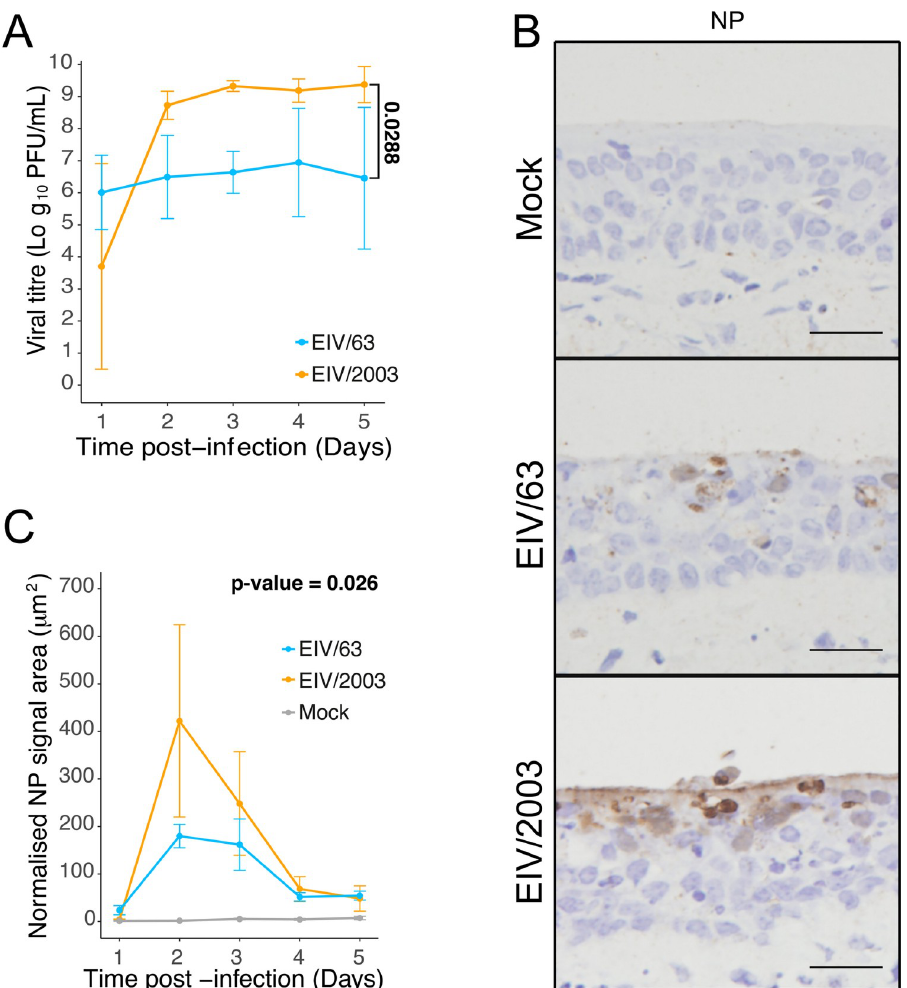
Fig 6. Growth kinetics and tissue distribution of EIV/63 and EIV/2003 in equine tracheal explants. (A) Growth kinetics of EIV/63 (cyan) and EIV/2003 (orange) in equine tracheal explants. Viral titres are represented as the mean ± SD of triplicate experiments. (B) Representative images of immunohistochemical staining using an anti-NP antibody in explants infected with EIV/63, EIV/2003 or mock-infected at day 2 post-infection. (C) Quantification of NP staining from day 1 to day 5 pi. Cyan, orange, and grey lines represent explants infected with EIV/63, EIV/2003 and mock-infected, respectively. Antigen quantification is summarised as the mean ± SEM of three images per section per timepoint on three independent sections. P-values are shown in bold when significant and were calculated using generalized linear mixed-effects models.